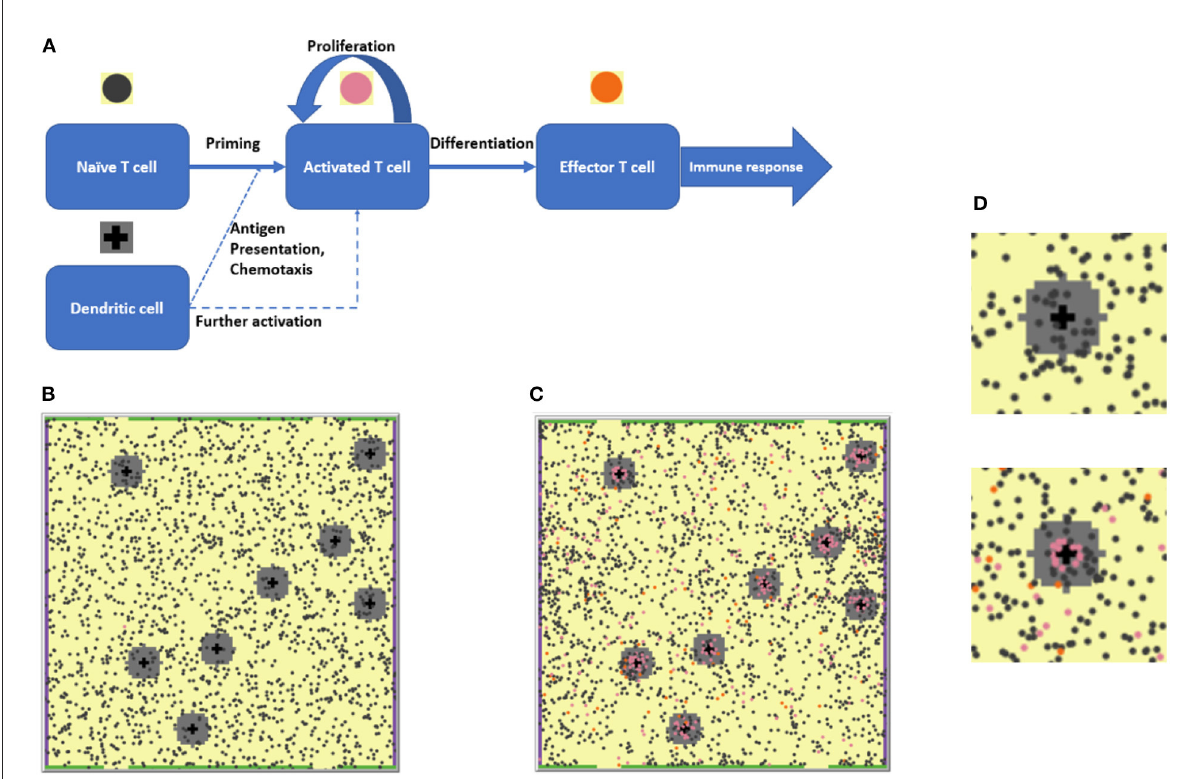
FIGURE1 (A) The agent-based modeling (ABM) framework: Schematic of states and processes of the two main agents, T cells and dendritic cells (DCs) represented in the model. (B) 2D ABM model simulation snapshot at the beginning of a simulation: 2,000 naïve T cells (dark gray circles) are present. (C) Snapshot of that particular simulation on Day 28: A number of naïve and activated T cells (pink circles) proliferated and differentiated into effector T cells (orange circles). (D) Enlarged fragments of snapshots (B,C) , with the upper left DC seen in (B,C) surrounded by a chemokine cloud and T cells at various stages of activation. The upper panel corresponds to the simulation start, the lower panel corresponds to the 28th simulation